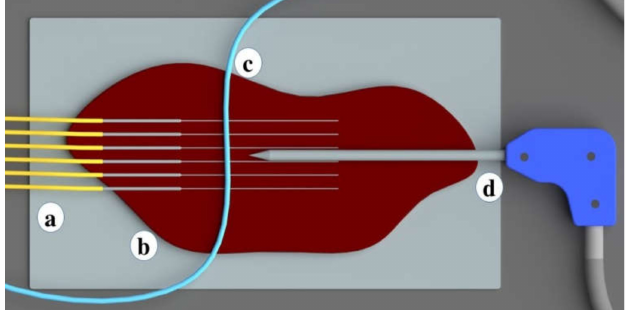
Figure 3. Schematic overview of the radiofrequency ablation setup. The setup includes ( a ) OBR and data logging; ( b ) RF generator; ( c ) the syringe pump; ( d ) a medical tube located perpendicularly to the optical fibers; ( e ) six optical fibers to register the temperature change; ( f ) parenchymal tissue; and ( g ) an applicator of the hybrid generator inserted between 3rd and 4th optical fibers.